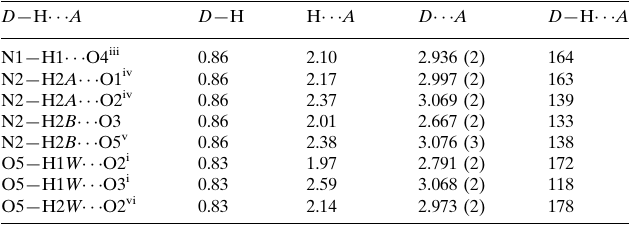
Hydrogen-bond geometry (A˚ , (cid:4)